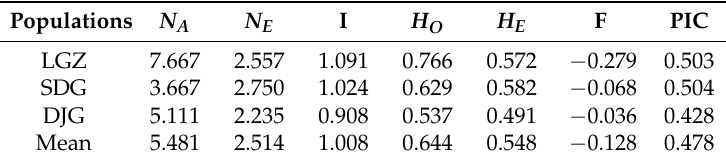
Table 5. Genetic diversity of the three populations of T . koraiensis . Populations N A